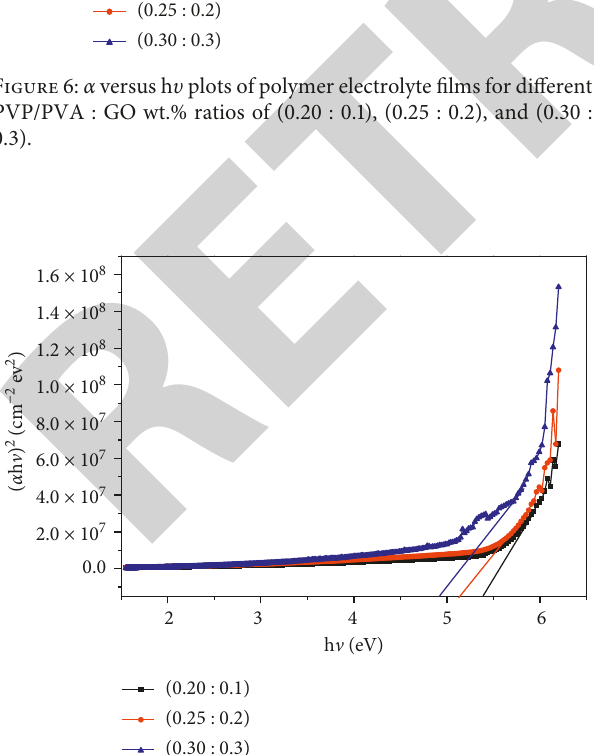
Figure 7: α versus ( α h υ ) 2 plots of polymer electrolyte films for different PVP/PVA : GO wt.% ratios of (0.20 : 0.1), (0.25 : 0.2), and (0.30 : 0.3).